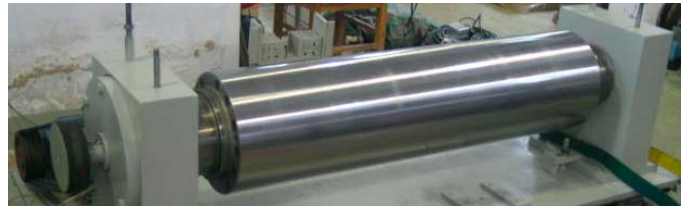
Figure 12. Shapemeter roll prototype.